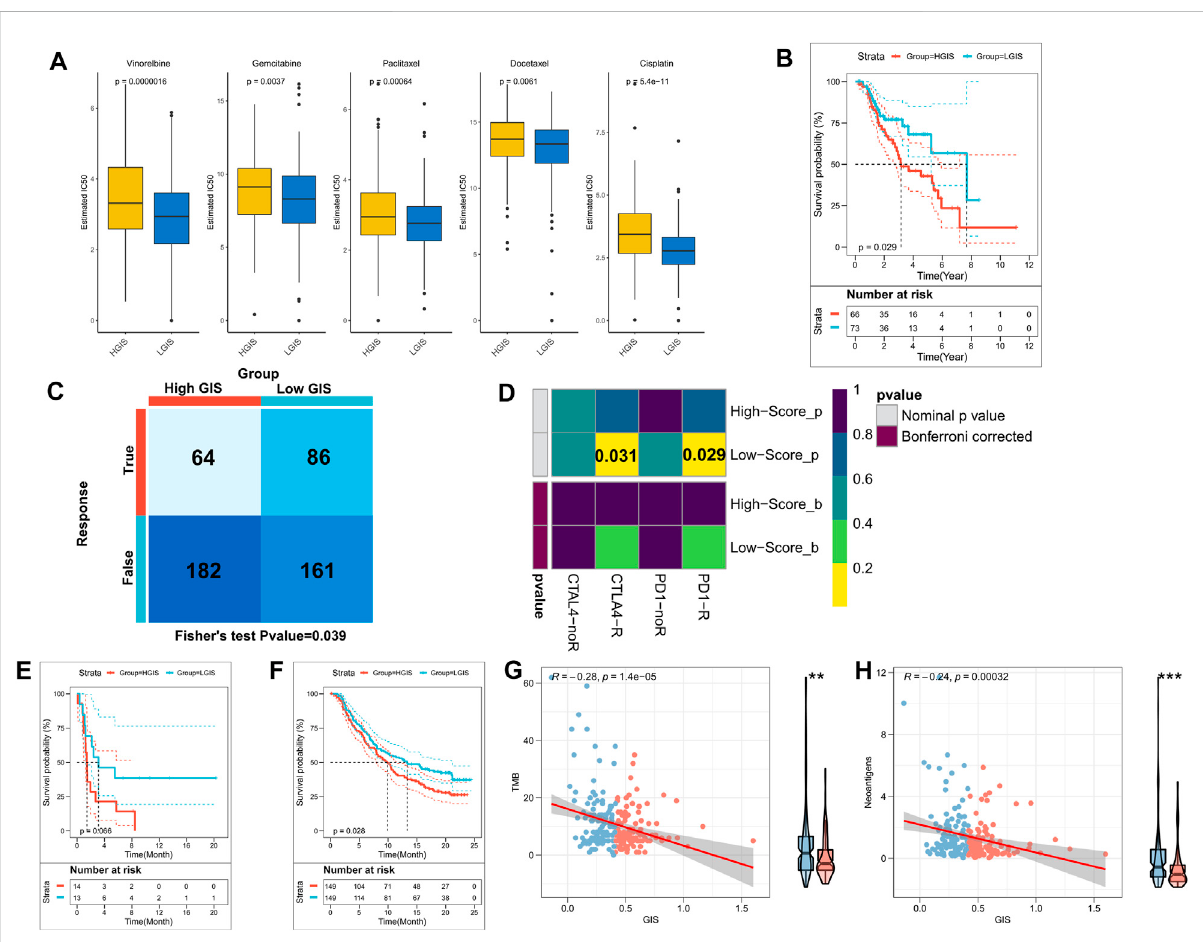
FIGURE 7 The GIS model guides the clinical treatment decision. (A) Box plot of the predicted IC50 values of fi ve commonly used lung cancer drugs in the high and low GIS groups. (B) KM survival curves of patients receiving chemotherapy in the TCGA cohorts with high and low GIS. (C) The TIDE algorithm wasusedto predicttheoverallresponserateto immunotherapyinthehighandlow GISgroups. (D) Subclassmappingwasusedto predict the sensitivity of patients in the high and low GIS groups to anti-PD1 and anti-CTLA4 therapy. (E) KM survival curves of high and low GIS groups intheGSE135222cohort. (F) KMsurvivalcurvesofthehighandlowGISgroupsintheIMvigor210cohort. (G) CorrelationbetweenGISandTMBinthe IMvigor210 cohort. (H) Correlation between GIS and neoantigens in the IMvigor210 cohort. GIS, glycolysis – immune score; GSEA, gene set enrichment analysis; TMB, tumor mutation burden; KM, Kaplan – Meier; TCGA, The Cancer Genome Atlas; TIDE, Tracking of Indels by